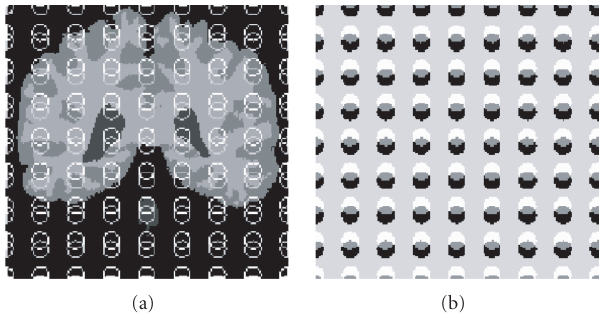
Figure 2: Initialization of the four-phase level set segmentation method. (a) Original MRI slice with two sets of circles initialized over the entire image. (b) Corresponding partitioning of the image domain into four phases defined by the overlap of the two level set functions obtained from the cylindrical